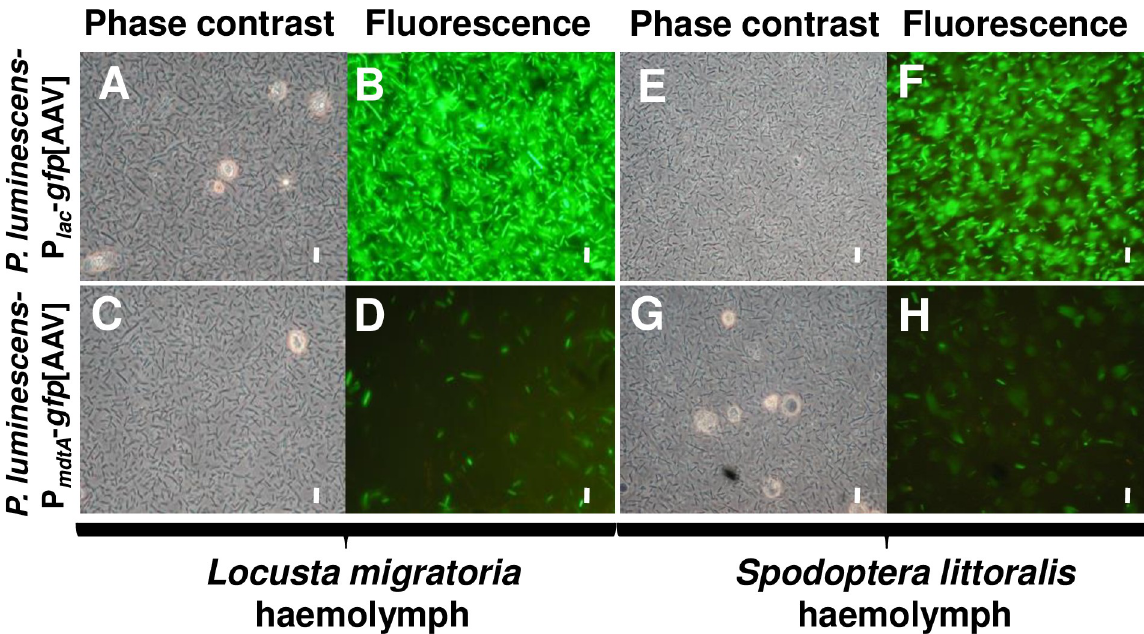
Fig 4. Comparison of the in vivo expression of the Photorhabdus luminescens mdtABC operon and constitutive GFP expression in Locusta migratoria and Spodoptera littoralis haemolymphs. Insects were injected with wild-type P . luminescens harbouring a transcriptional fusion between E . coli P (A, B, E, and F) or the mdtABC (C, D, G, and H) promoter and the gfp [AAV] reporter gene. Haemolymph was regularly lac extracted from infected larvae during infection, observed under a light microscope (A, C, E, and G) and fluorescence was determined (B, D, F, and H). The observations shown were made at 20 to 24 hours post-injection for S . littoralis larvae and at 30 hours post-injection for L . migratoria , and correspond to the results of at least three independent experiments. Scale bar represents 10 μ m.